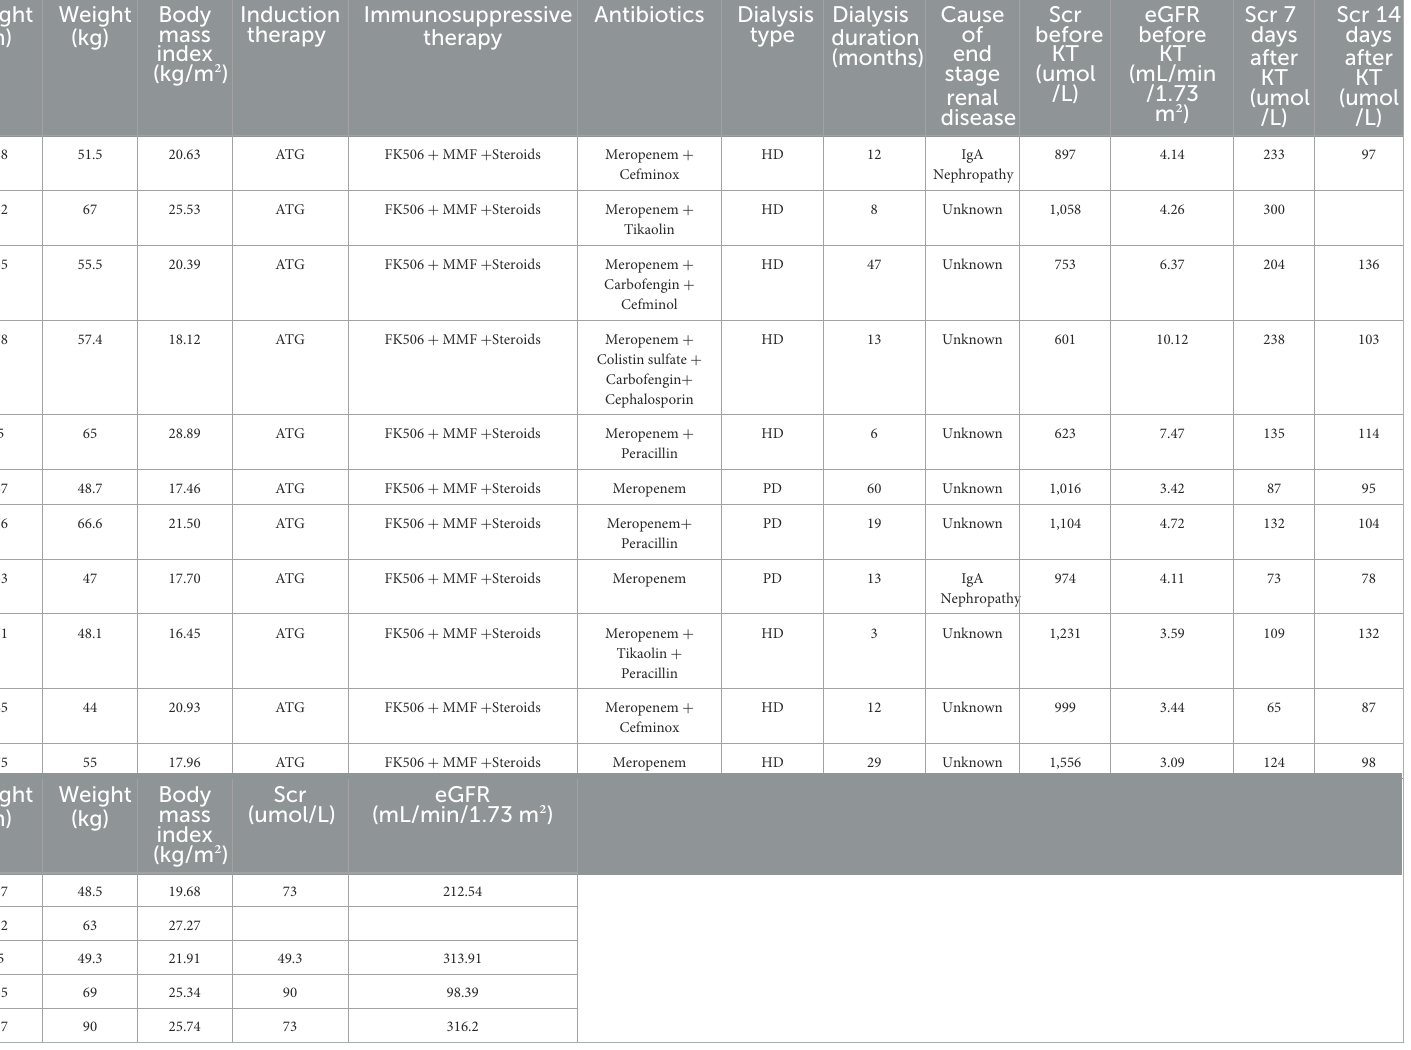
TABLE 1 Characteristics of renal transplant patients and control subjects. Patient